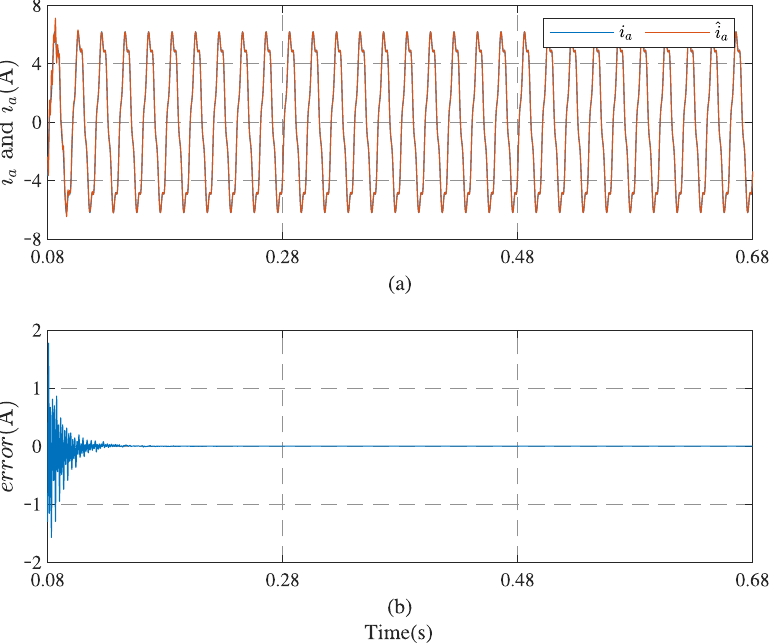
Figure 7. ( a ) Comparison between reconstructed current ˆ i a and original current i a . ( b ) Error